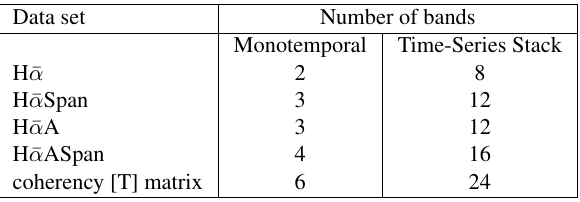
Table 2. Number of features